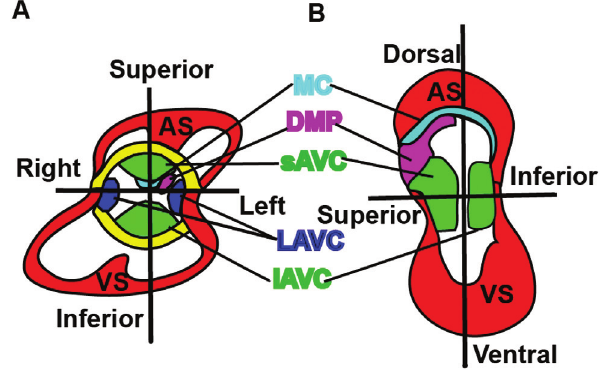
Figure 4: Five mesenchymal /muscular tissues contribute to atrio- ventricular